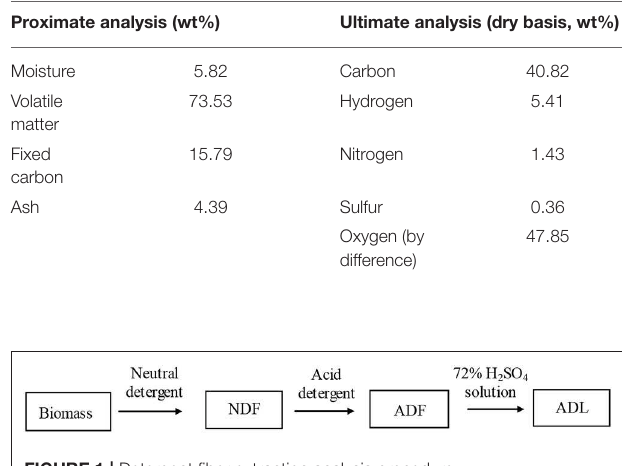
FIGURE 1 | Detergent fiber extraction analysis